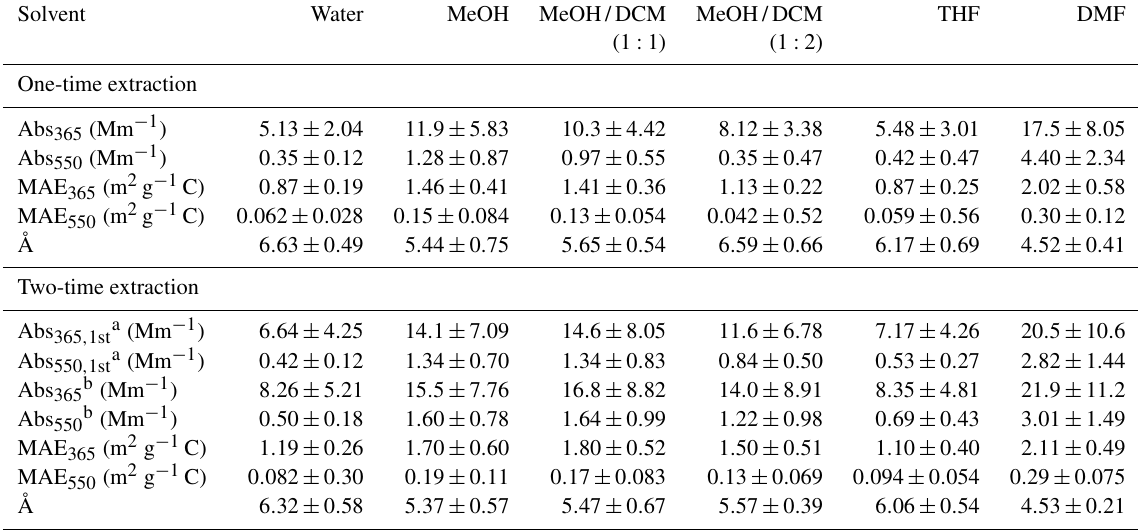
Table 2. Light-absorbing properties of SEOC following one-time and two-time extraction procedures. Solvent Water MeOH MeOH/DCM MeOH/DCM THF DMF (1 : 1) (1 : 2) One-time